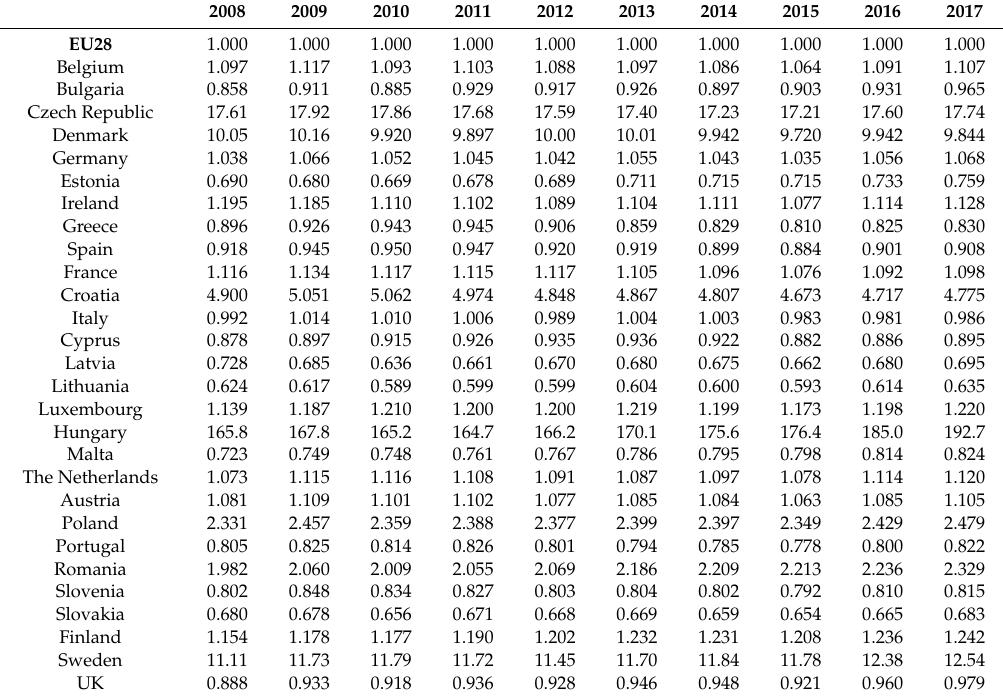
Table 1. Purchase Power Parity (PPP) in EU28 (European Statistics